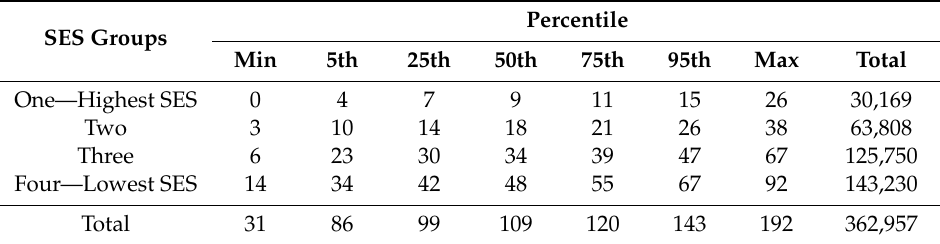
Table 2. Descriptive statistics of daily mortality count in the study